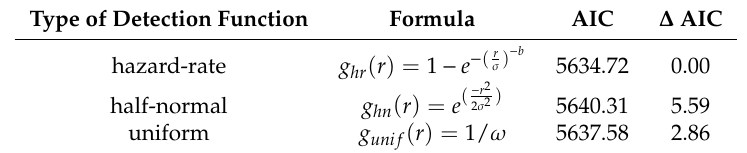
Table 1. AIC (Akaike’s Information Criterion)-based comparison of the candidate detection functions. Type of Detection